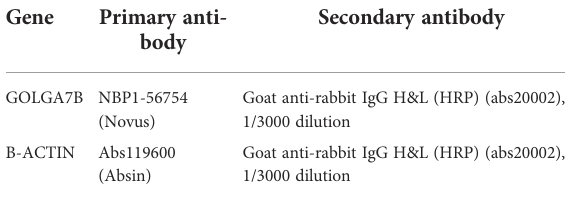
TABLE 3 The antibody information of the target